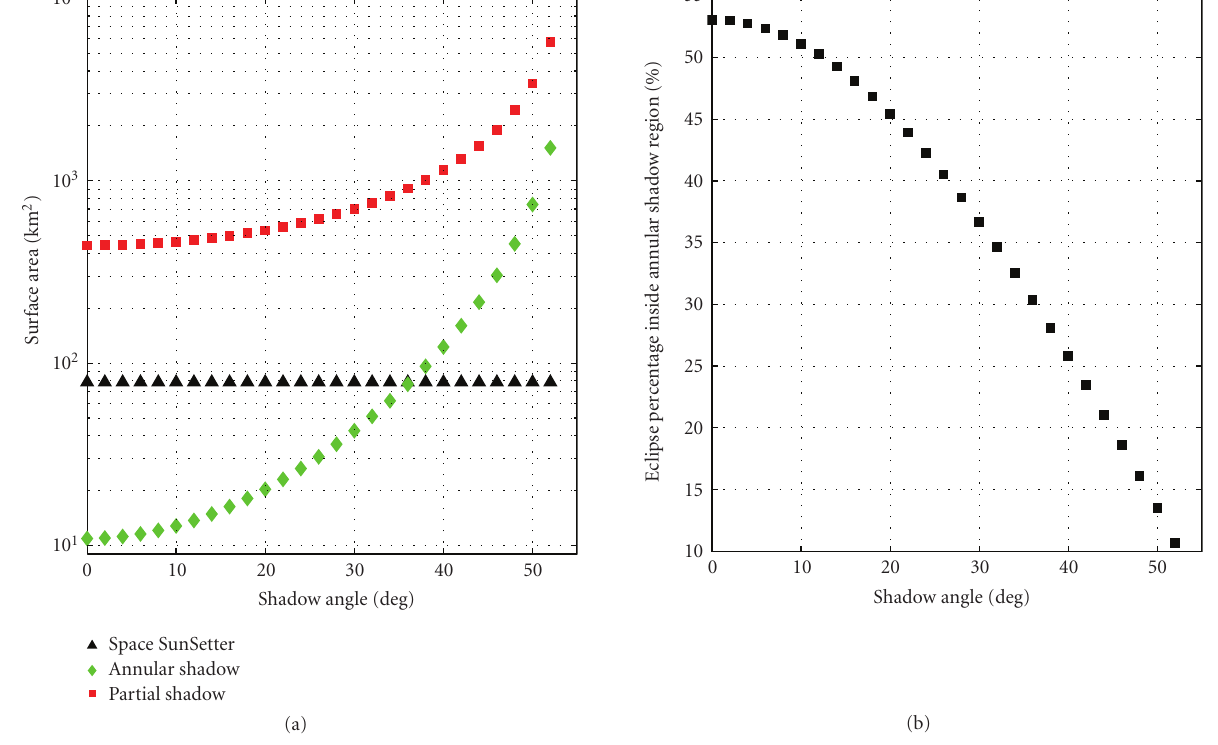
Figure 6: Space SunSetter with a radius of 5 km at 1500 km altitude.